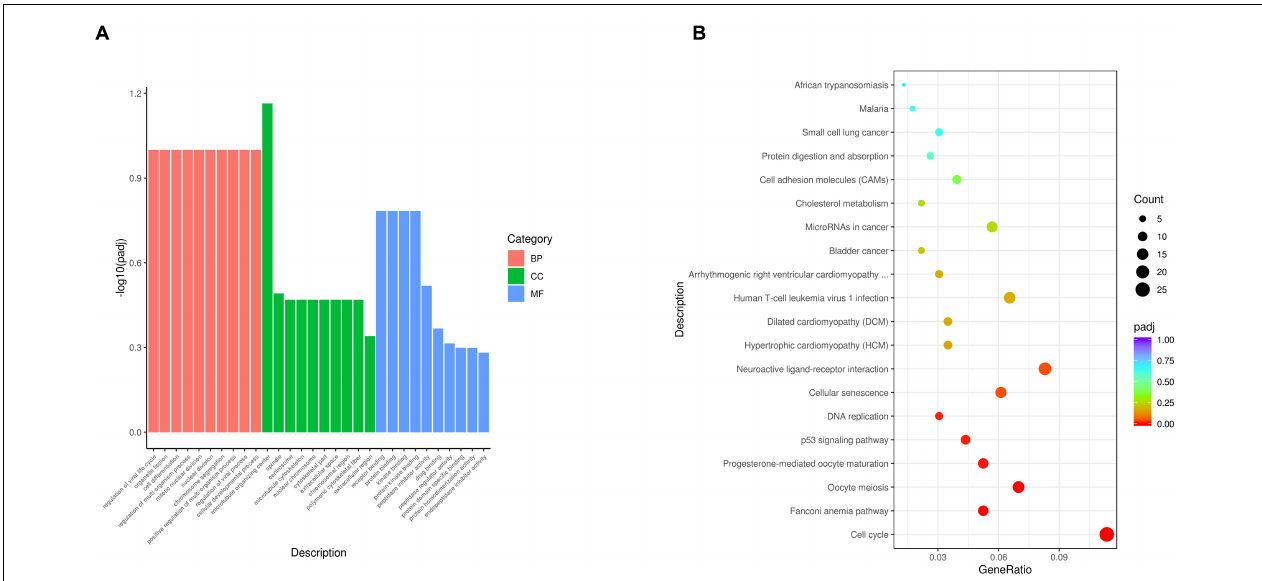
FIGURE 4 | Gene Ontology term enrichment analysis and KEGG pathway analysis are performed with 627 DEGs. (A) Representative items for each top 10 terms of biological process (BP), cellular component (CC), and molecular function (MF) are shown in red bars, green bars, and blue bars, respectively. The x -axis represents the name of GO terms. The y -axis represents –log10 (adjusted P -value) of GO terms. (B) The top 20 enriched KEGG pathways of 627 DEGs are shown. The x -axis represents the gene ratio. The y -axis represents the names of KEGG pathways. The gene ratio means the ratio between the number of genes related to the corresponding pathway and the total number of genes in the